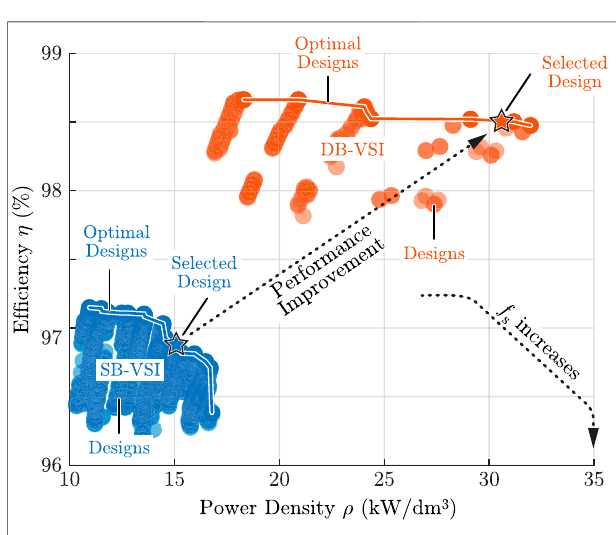
FIGURE 6 | Multiobjective optimization results for the DB-VSI and the SB-VSI technology with respect to inverter ef fi ciency η and power density ρ , for a design space with different switching frequencies f s , semiconductor devices, inductance values L o , and capacitance values C o and C i . The selected DB-VSI design is highlighted with a star and the respective component values are given in Table 3